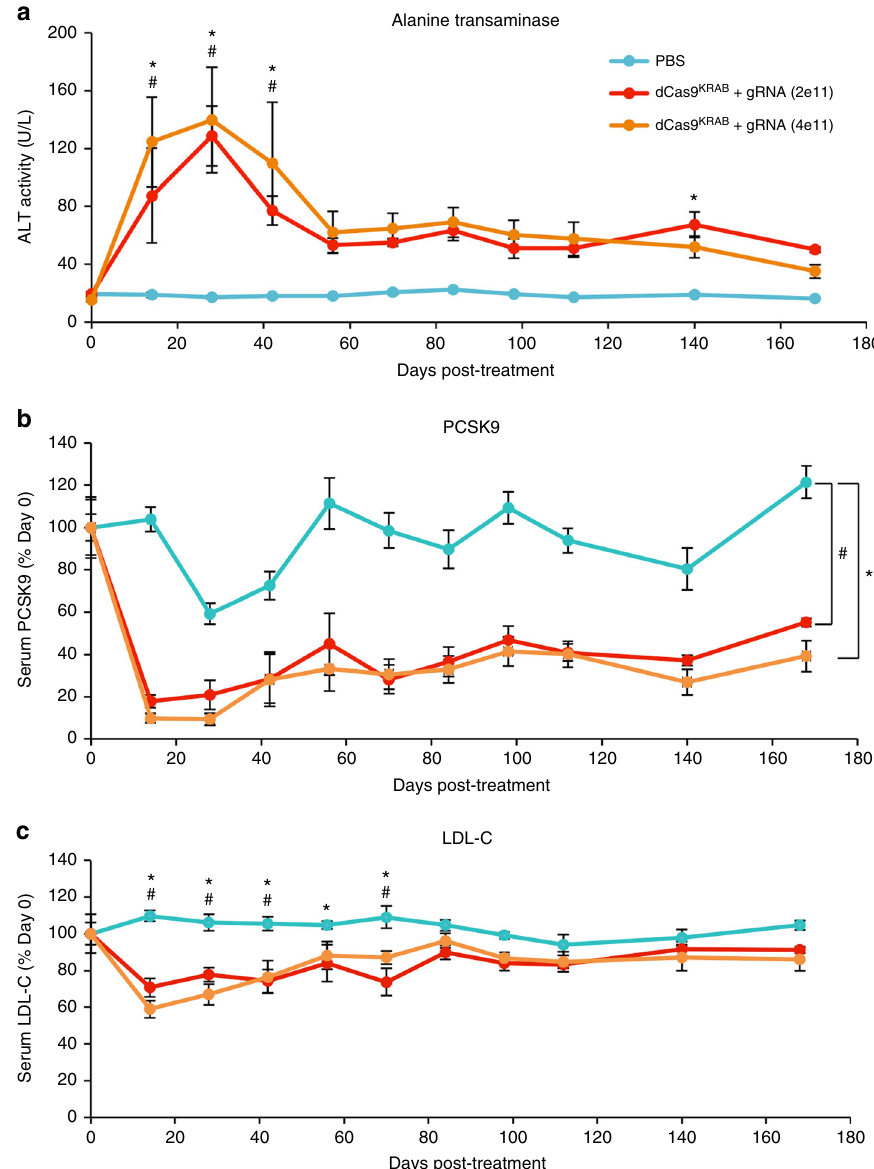
Fig. 5 Long-term ef fi cacy of targeted transcriptional silencing with dSaCas9 KRAB . In mice treated with AAVs expressing dSaCas9 KRAB and Pcsk9 -targeting gRNA at 2×10 11 and 4×10 11 viral genomes/vector/mouse, serum was collected over 168 days post-treatment and analyzed for a alanine transanimase secretion, b Pcsk9 protein concentration, and c low-density lipoprotein-cholesterol concentration (mean ± s.e.m., n = 4 mice at 6 – 8 weeks old when treated). * and # mark P < 0.05 in 2e11 and 4e11 doses respectively, calculated by mixed design ANOVA with Tukey ’ s post-hoc analysis compared to